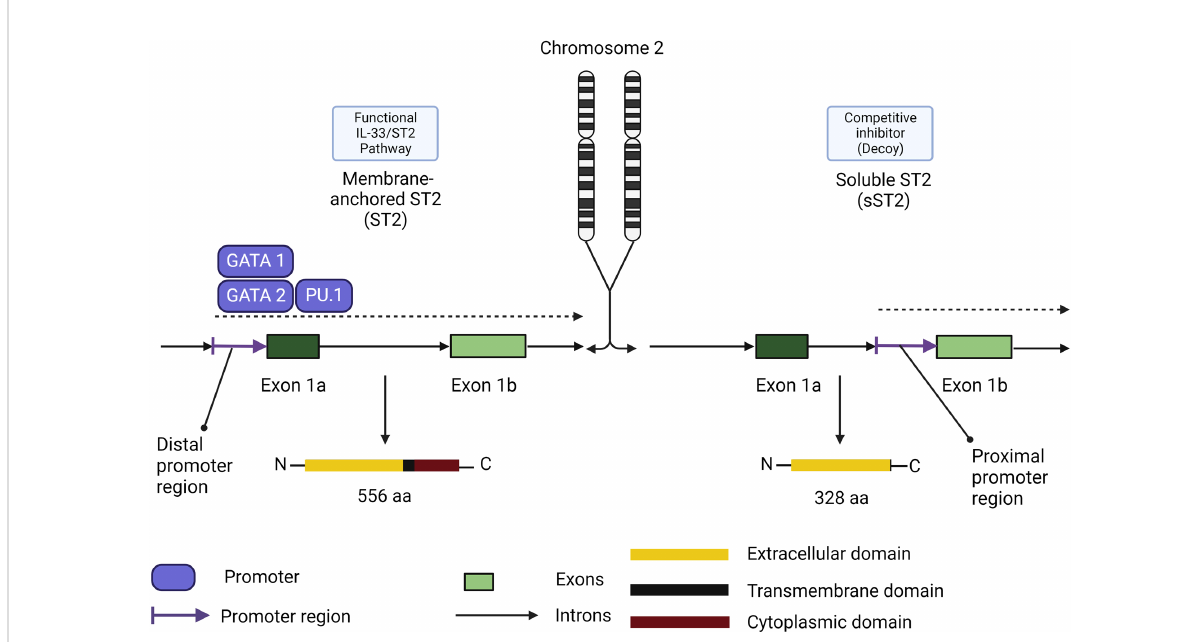
FIGURE 6 Membrane-anchored ST2/soluble ST2 isoforms functional differences in role and expression. Membrane-anchored ST2 (ST2) expression is controlled by the distal promoter region through the promoters GATA1, GATA2 and PU.1. ST2 comprises the functional receptor in the IL-33/ ST2 signaling pathway. Soluble ST2 (sST2) expression is controlled by the proximal promoter region. Its promoters remain to be elucidated and the isoform share the same extracellular domain which makes sST2 a competitive inhibitor of ST2 in the IL-33/ST2 signaling